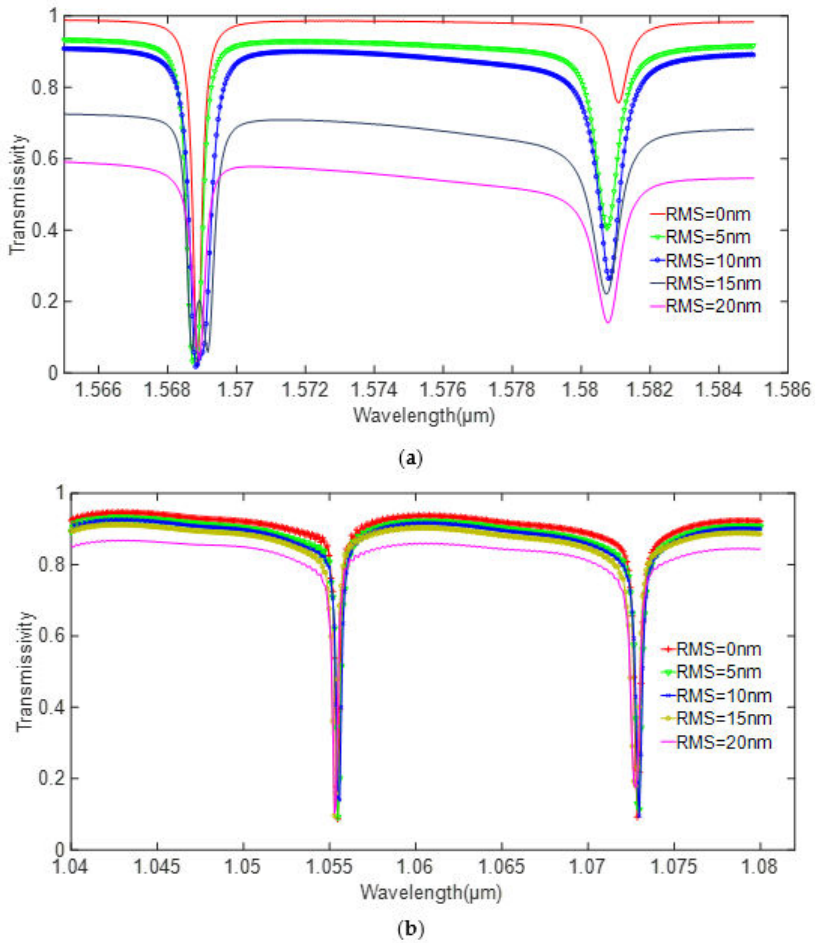
Figure 10. E ff ect of roughness on scattering loss. ( a ) silicon. ( b ) silicon nitride.